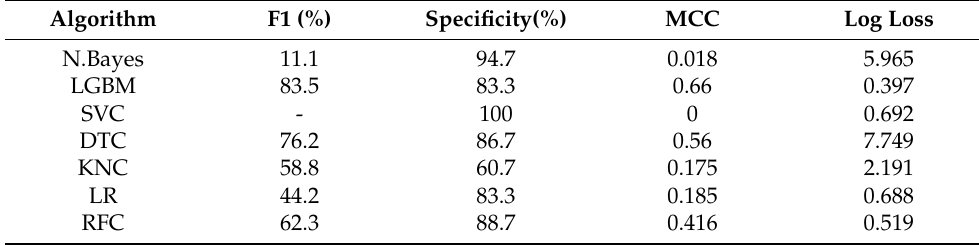
Table 5. The obtained other performance metrics results using 16 channels of EEG signals with machine-learning classification